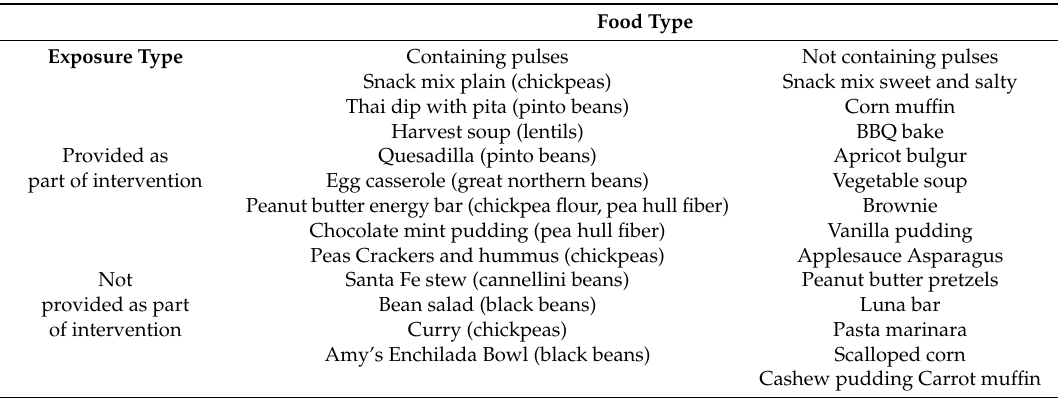
Table 1. The 28-food item taste test battery for study participants classified according to exposure and food